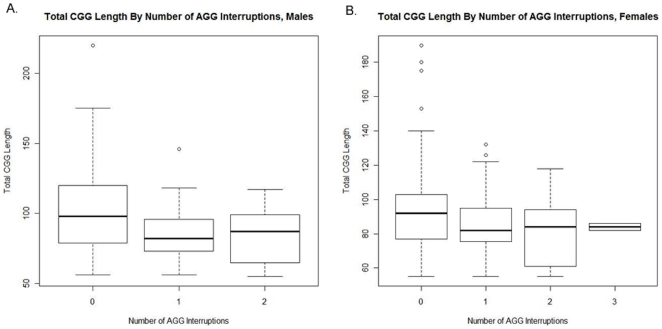
A box plot of total CGG length for each number of AGG interruptions.A) In premutation male data, significant difference in total CGG length of subjects with no AGG interruptions (130 subjects) and those with 1 or 2 interruptions (96 and 55 subjects respectively) was found (P<0.001 in both cases). No significance was found in total CGG length of subjects with 1 AGG interruption compared to 2 AGG interruptions (P = 0.935). B) Premutation female data showed significant difference in total CGG length of subjects with no AGG interruptions (259 subjects) and those with 1 or 2 interruptions (143 and 78 subjects respectively) (P<0.001) but no difference with remaining pairs.